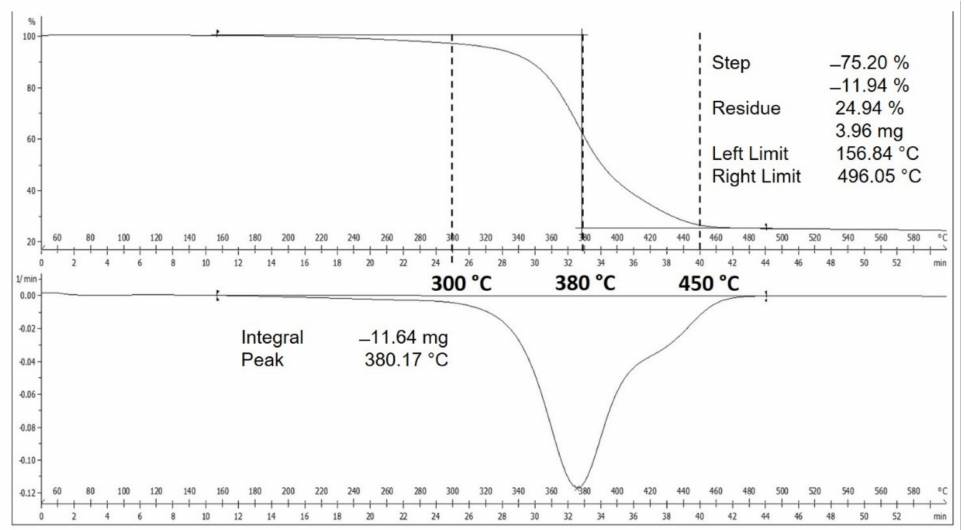
Figure 3. TGA and DTG curves of waste